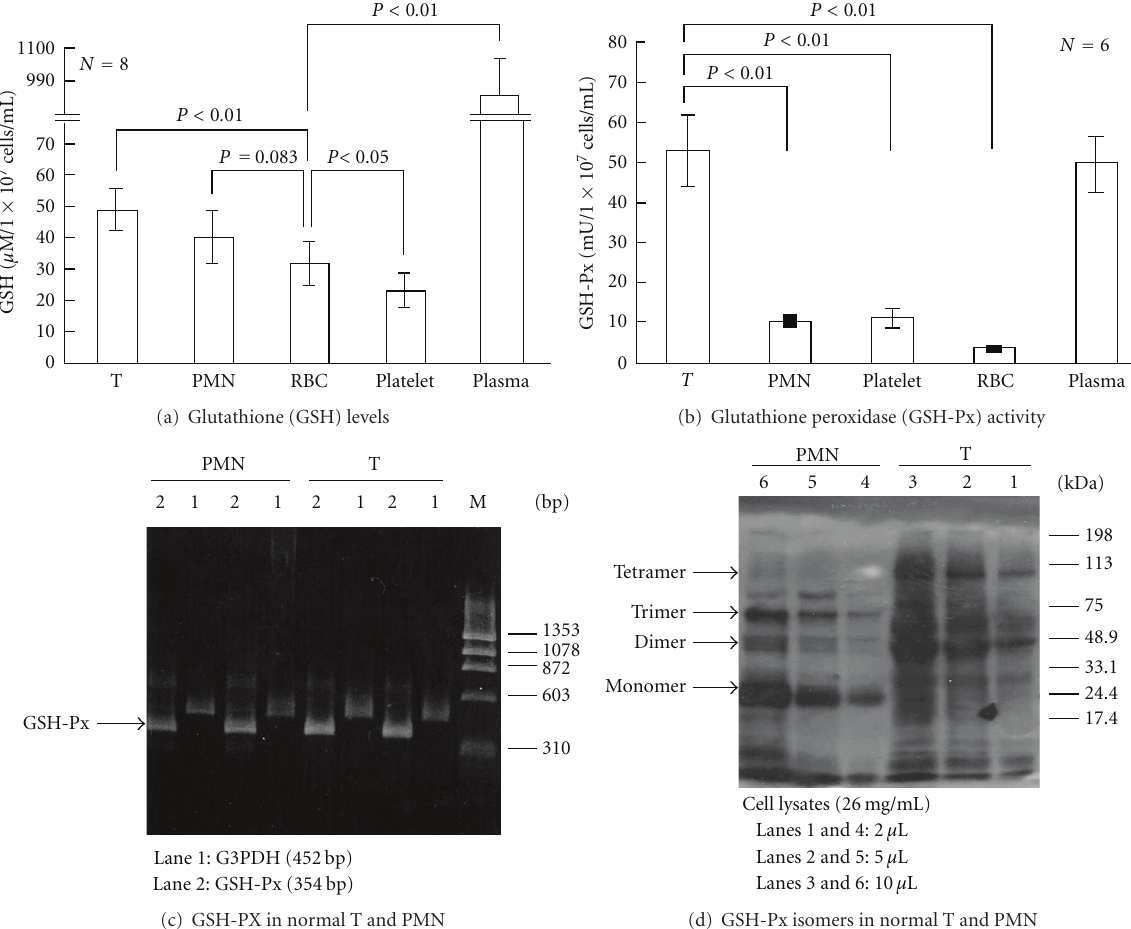
Figure 4: Comparison of intracellular reduced-form glutathione (GSH) levels, enzyme activity, and gene expression of glutathione peroxidase (GSH-Px) in the plasma and di ff erent blood cell populations of normal individuals. (a) Intracellular GSH levels ( μ M/1 × 10 7 cells/mL) in T, PMN, red blood cells, platelets, and plasma of normal individuals. (b) GSH-Px enzyme activity (mU/1 × 10 7 cells/mL) in plasma and di ff erent blood cells of normal individuals. One milliunit (mU) of GSH-Px enzyme activity is the activity that catalyzes the oxidation of 1nmol NADPH/mL/min. (c) Expression of GSH-Px mRNA in T and PMN of two normal individuals by RT-PCR, lane 1: G3PDH (452bp, as internal control), lane 2: GSH-Px (354bp). (d) A representative case demonstrating dose-response expression of GSH- Px isomers in a normal T and a normal PMN by Western blot. Three doses (2 μ L in lanes 1 and 4; 4 μ L in lanes 2 and 5; 10 μ L in lanes 3 and 6) of cell lysates (protein concentration 26mg/mL) were analyzed in Western blot probed by antihuman GSH-Px antibody. Four GSH-Px isomers are identified as monomer (25kDa), dimer (50kDa), trimer (75kDa), and tetramer (100kDa). Two normal samples exhibited a similar